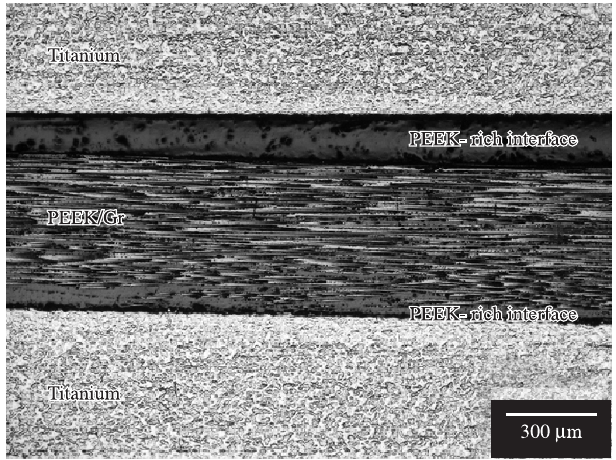
Figure 1. Longitudinal cross-section of TiGr laminate (all the constituents are identified).